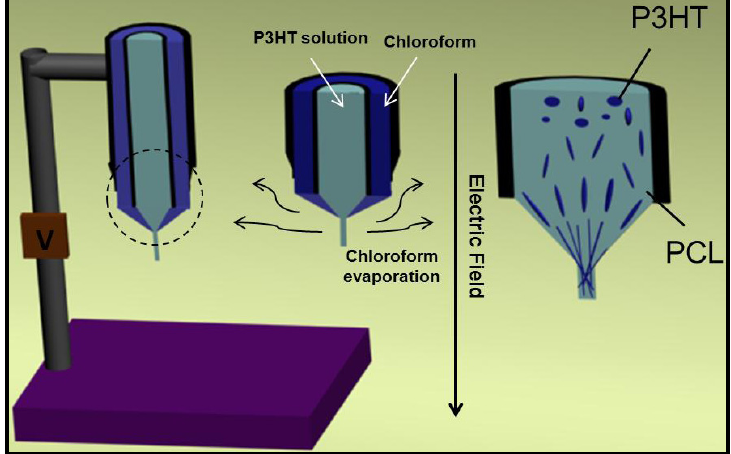
Figure 28. Schemes showing ( left ) the coaxial electrospinning setup for P3HT electrospinning and ( right ) the elongation of P3HT domains and formation of continuous P3HT fibrils from the elongation of P3HT domains in highly concentrated PCL